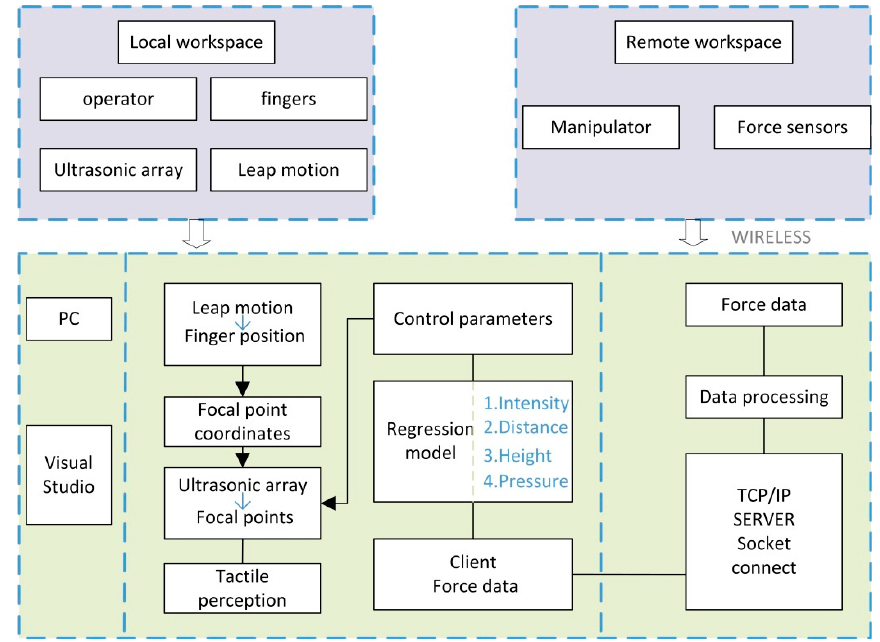
Figure 3. The overall flowchart of our proposed system. It includes the human-computer interac- tion terminal and the control terminal, as well as the method of data transmission and the method of realizing device